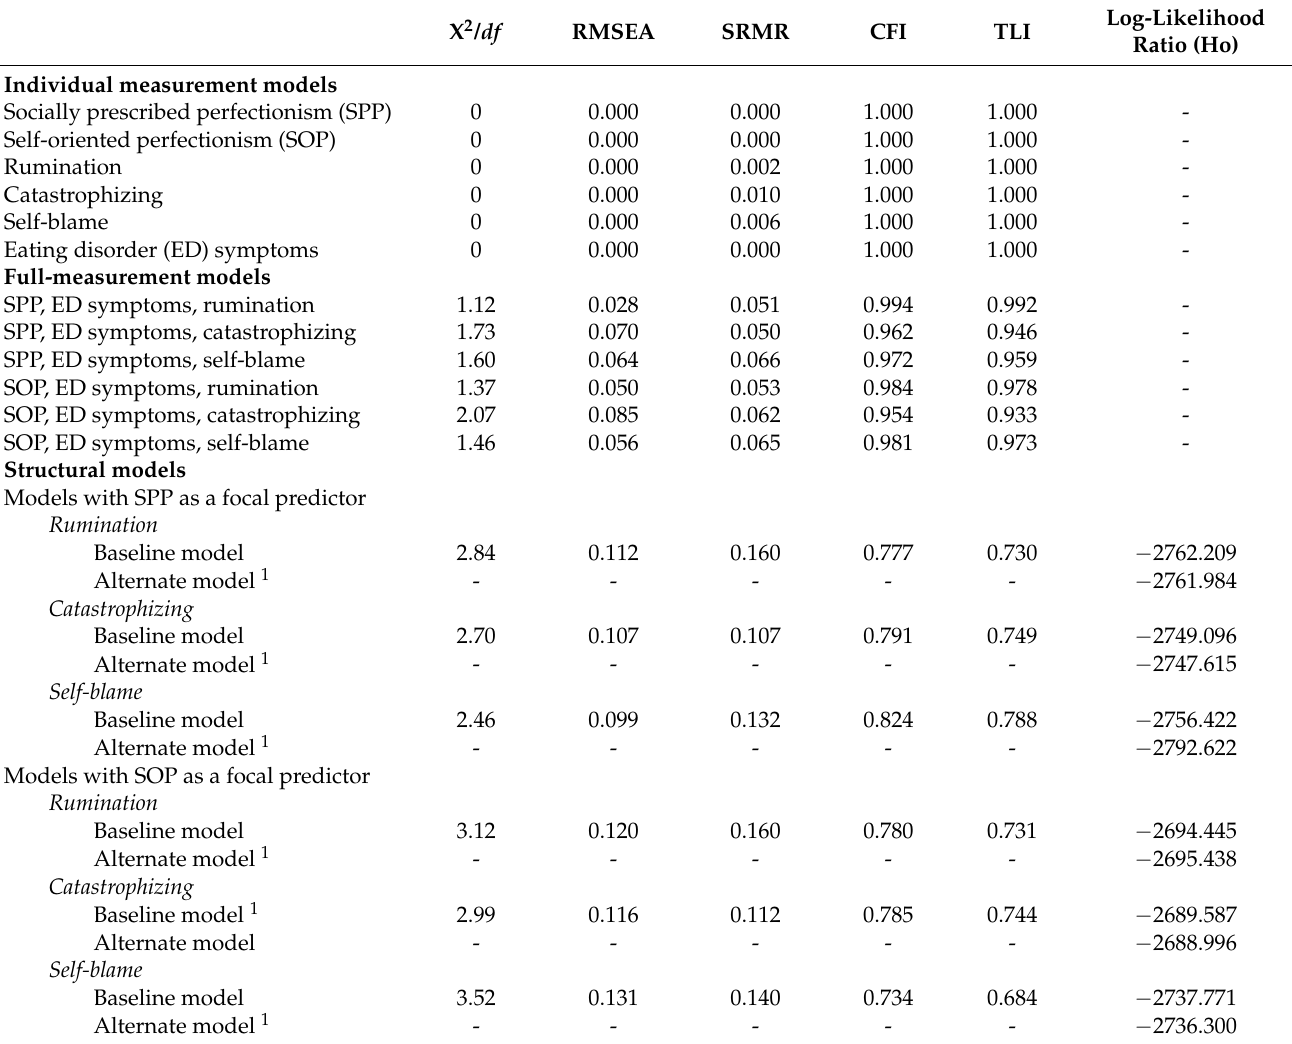
Table 3. Fit indices for measurement and structural